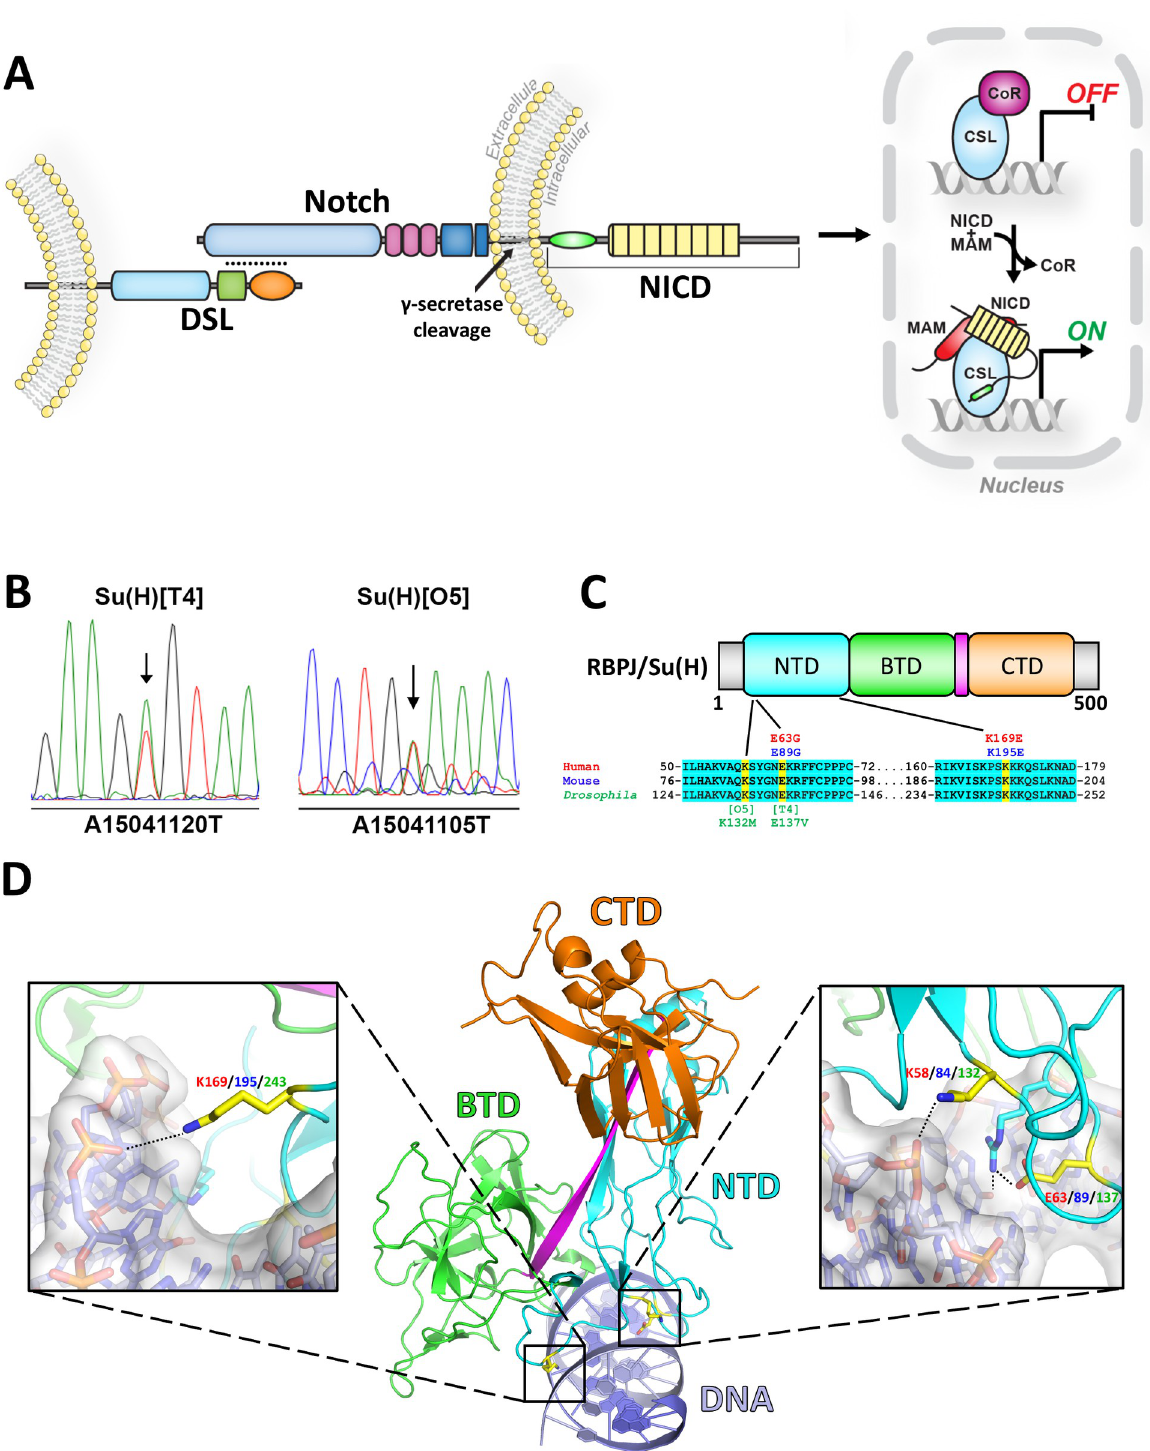
Fig 1. Variants in the Notch pathway transcription factor associated with Adams Oliver Syndrome. A. Overview of the Notch signaling pathway. Signal sending cells that express Notch ligands (DSL) interact with adjacent signal receiving cells that express Notch receptors. Upon receptor-ligand binding, the Notch receptor is cleaved by γ -secretase, resulting in the release of the soluble Notch Intracellular Domain (NICD). NICD binds to the CSL transcription factor and recruits the co-activator Mastermind (MAM) to activate transcription of Notch target genes. The CSL transcription factor can also engage co-repressors (CoR) to inhibit transcription. B. Sequence traces from PCR amplified genomic DNA